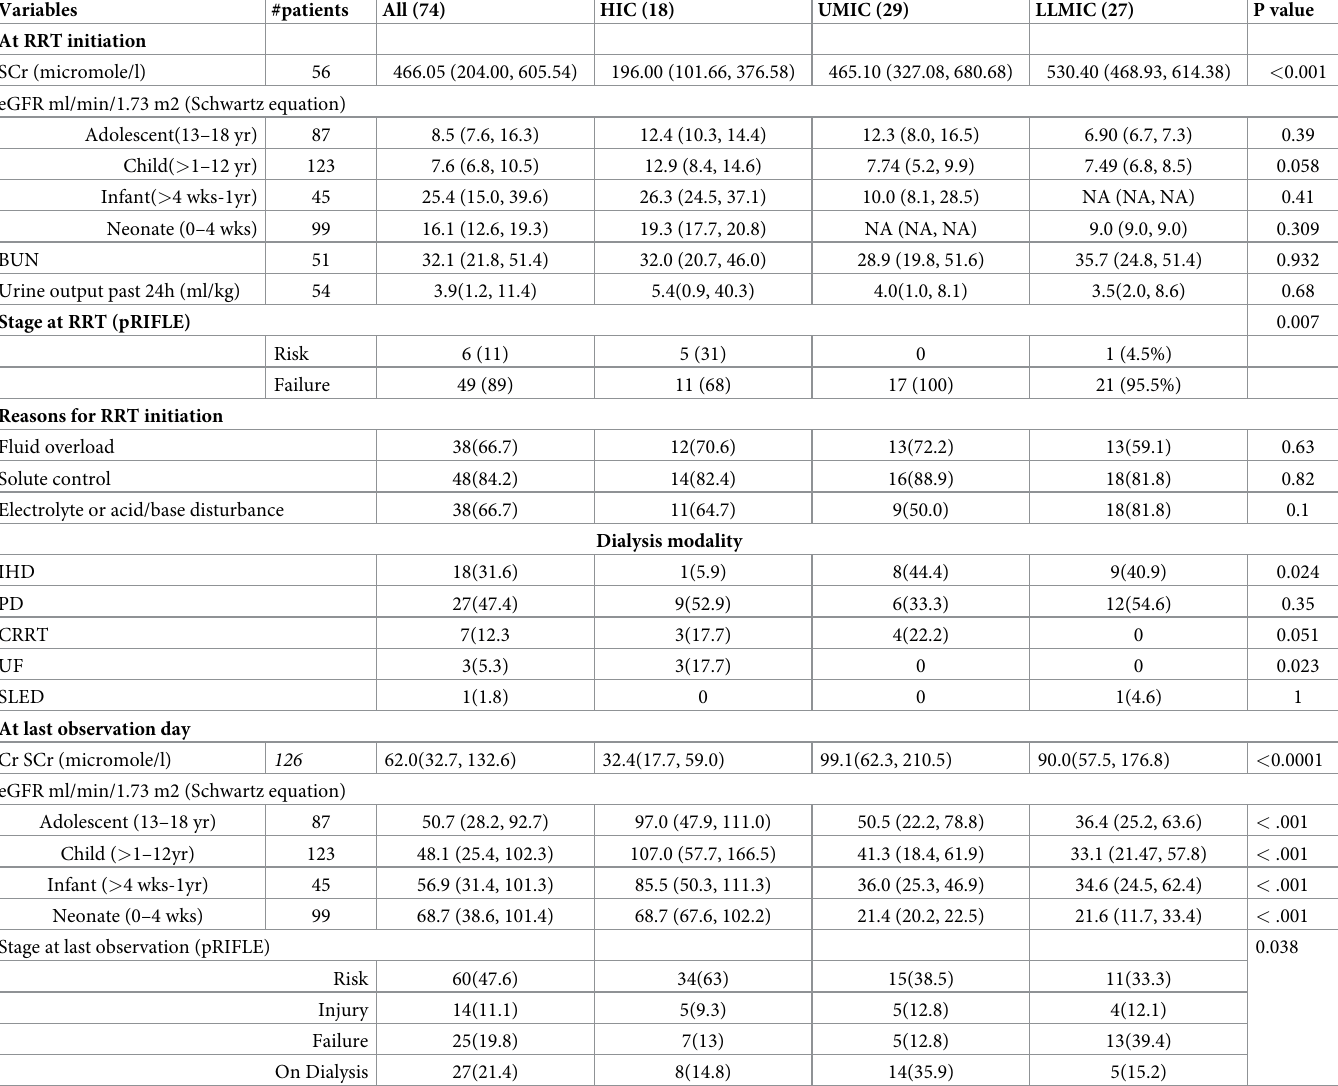
Table 3. Renal replacement treatment (RRT) characteristics, renal function at RRT initiation and at hospital